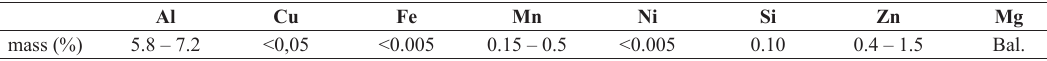
Table 1. Nominal chemical composition of the AZ61 alloy 26 .